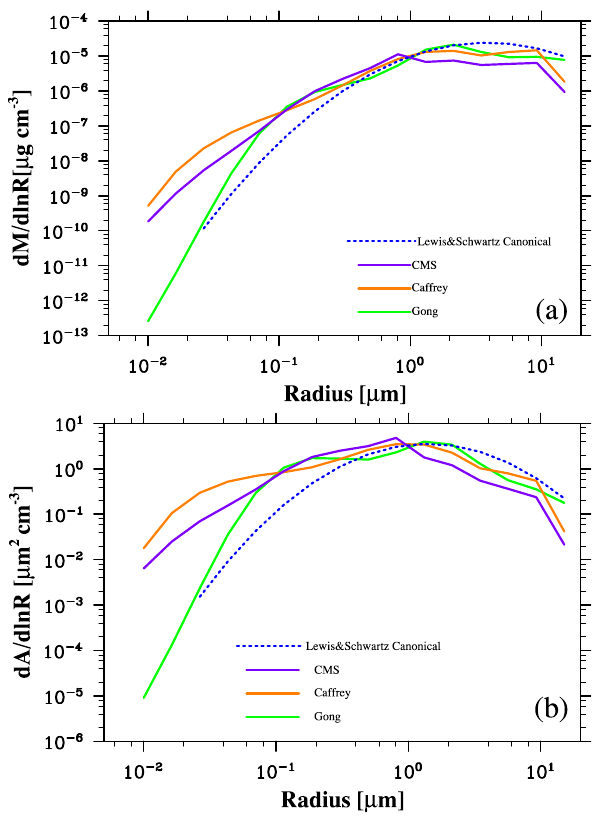
Fig. 17. Same as Fig. 15 except for (a) mass and (b) cross-sectional area size distribution.